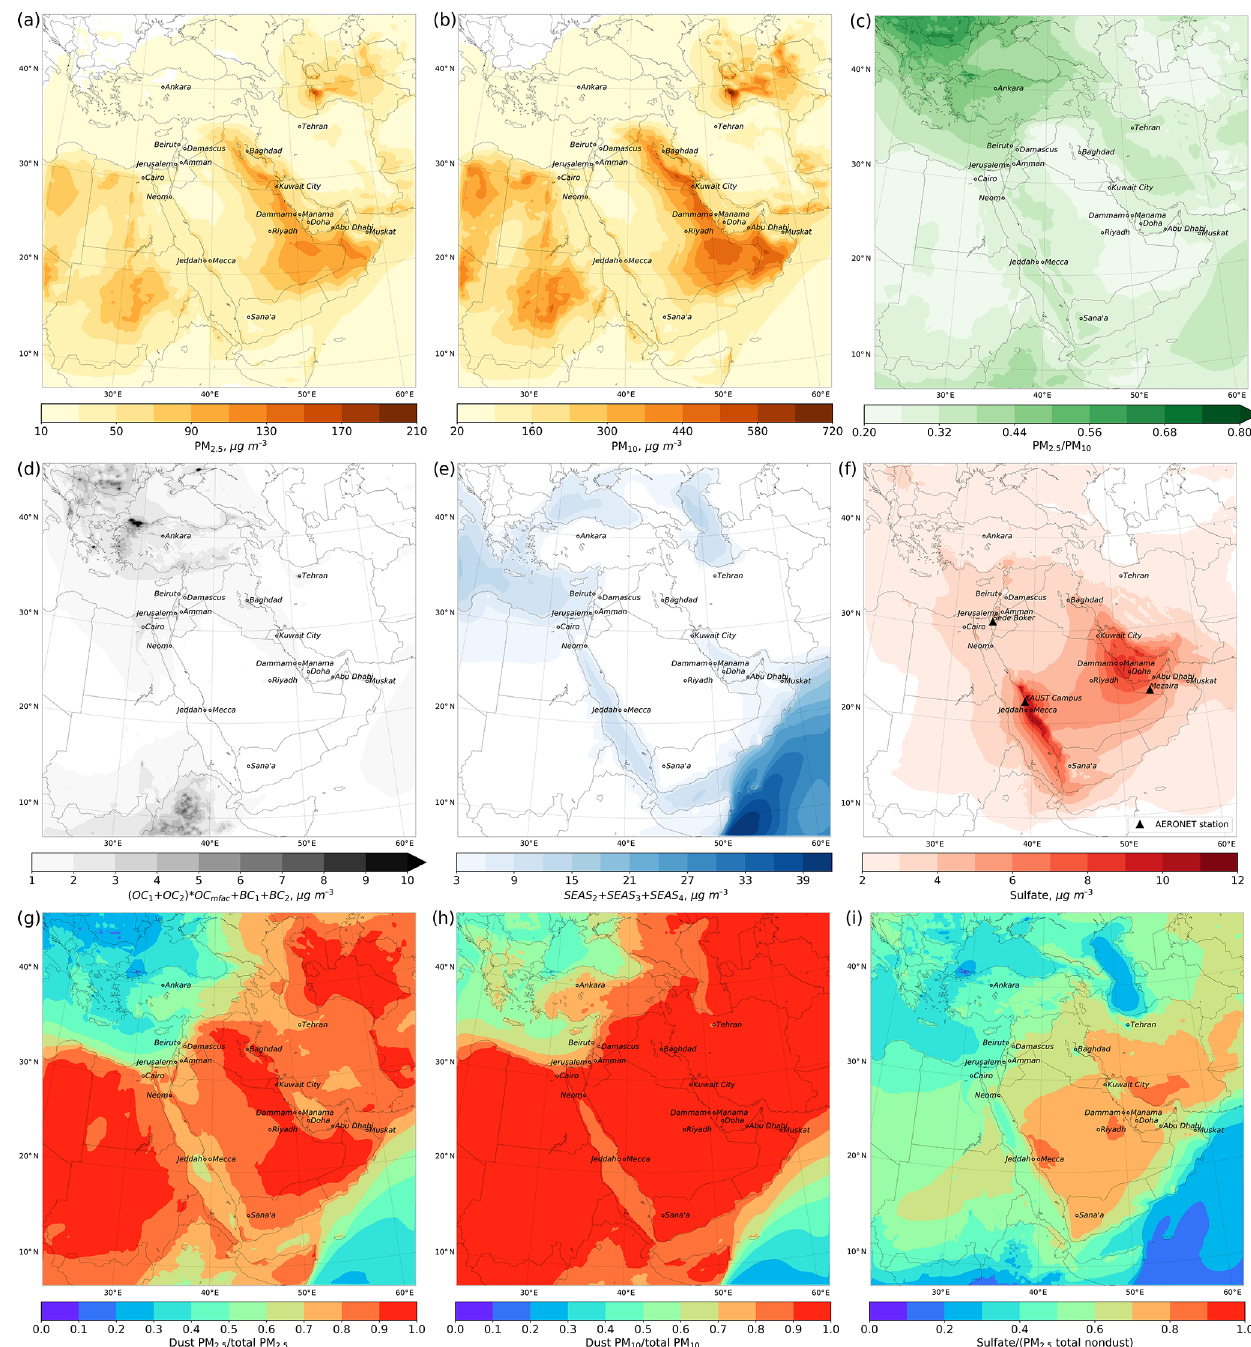
Figure 10. WRF-Chem’s average 2015–2016 surface concentrations (µgm − 3 ): (a) PM 2 . 5 ; (b) PM 10 ; (c) PM 2 . 5 / PM 10 ratio; (d) black carbon and organic matter, ( OC 1 + OC 2 ) × OC mfac + BC 1 + BC 2 , (µgm − 3 ); (e) sea salt, SEAS 2 + SEAS 3 + SEAS 4 , (µgm − 3 ); (f) sulfate (µgm − 3 ) and locations of AERONET stations; (g) dust PM 2 . 5 / (total PM 2 . 5 ) ratio; (h) dust PM 10 / (total PM 10 ) ratio; (i) sulfate / (PM 2 . 5 total nondust) ratio. Abbreviations of the aerosols’ names correspond to those given in Sect.